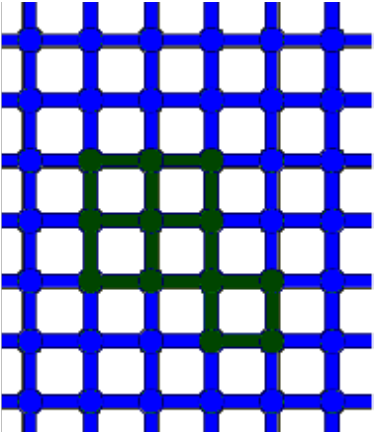
Figure 5. The problem of forming closed clusters. Green — oil, blue — displaced fluid.